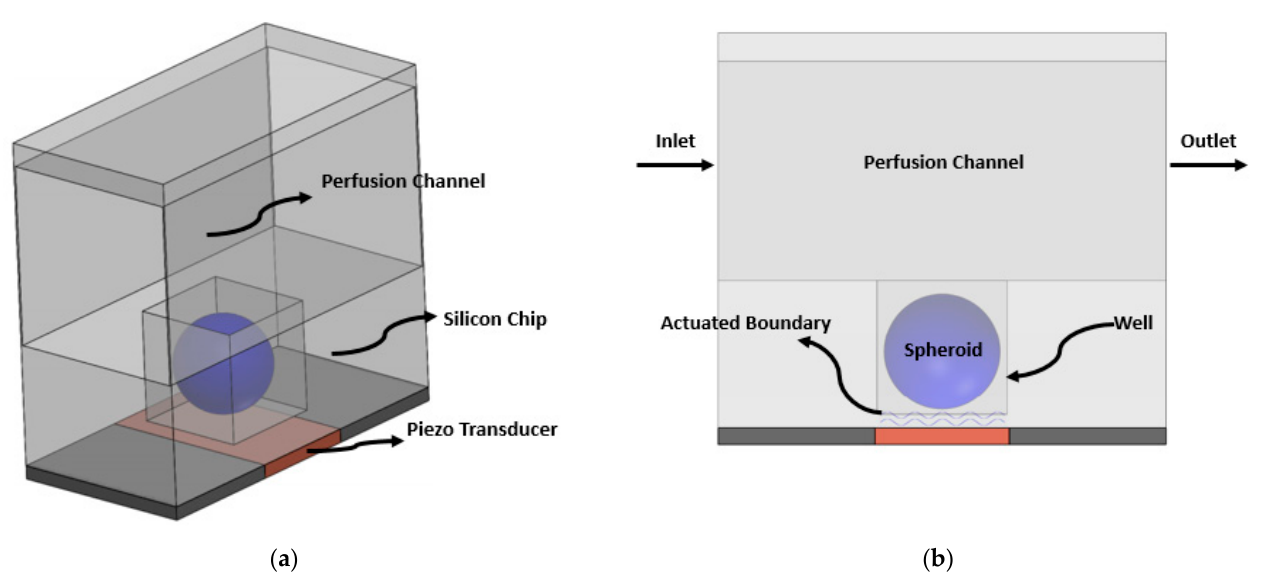
Figure 1. ( a ) 3D format and ( b ) 2D format of the schematic of the proposed acoustic-microfluidic system for 3D cell culture The geometry of a spheroid by its nature is 3D (i.e., a sphere). When modeling it in a 2D domain as a circle, we are only observing the midplane of the system and neglecting the effect of the third dimension on the system. Theoretically, this 2D model represents more quantitatively an infinite cylindrical cell aggregate and more qualitatively a spherical cell aggregate. Using a 3D model was computationally prohibitive in this work, as the number of mesh elements increases non-linearly with the frequency, and for our MHz-range simulation, a 3D solution was not affordable. While the simulation results are not exactly the same for a 3D model, they provide a good qualitative solution for the proof-of-concept study. Additionally, we hold the conviction that our simulation results are much more comparable to a spherical cell aggregate model rather than a finite cylindrical one. Consider a finite cylinder. For this model, there is a sharp difference in the flow field between the middle of the domain and its ends. However, there is no such difference between the middle and the end sections for a spherical model. The flow cell consists of a perfusion channel and microwell in which the spheroid is cultured. Beneath the flow cell, a piezo transducer is located.